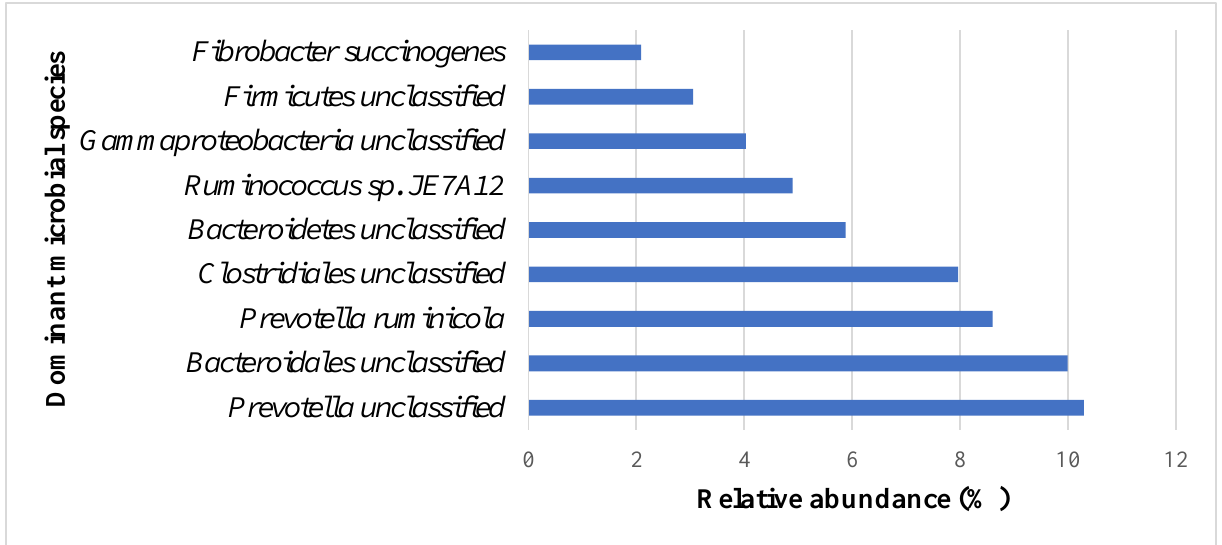
Figure 1. Relative abundance (%) of the 9 most dominant transcriptionally active taxa at the species level.